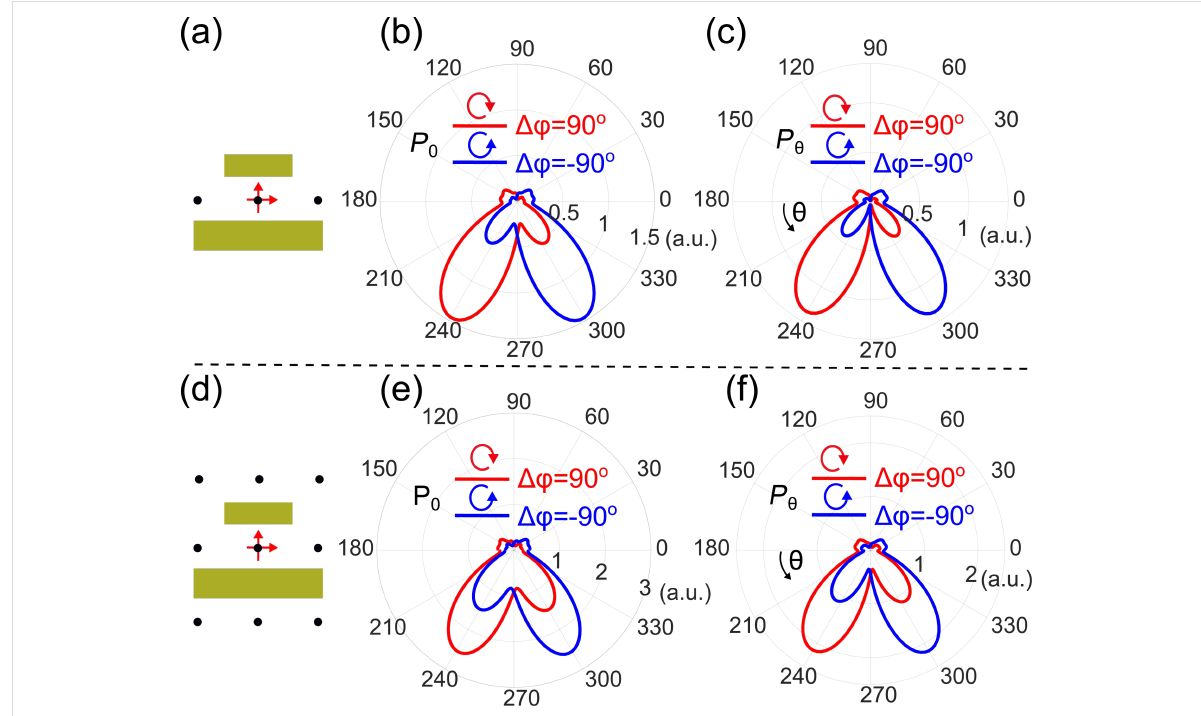
Figure 4: Emission pattern averaged over multiple emitters. (a) Schematic of the three emitter positions inside the gap between the two bars, used to evaluate the average effects. (b, c) Polar plot of the total ( P 0 ) and azimuthal component ( P θ ) of the far-field power distribution, after averaging over all three positions. (d) Schematic of the nine emitter positions used in simulations. (e, f) Polar plot of the total ( P 0 ) and the azimuthal ( P θ ) components of the far-field power distribution, after averaging over all the nine